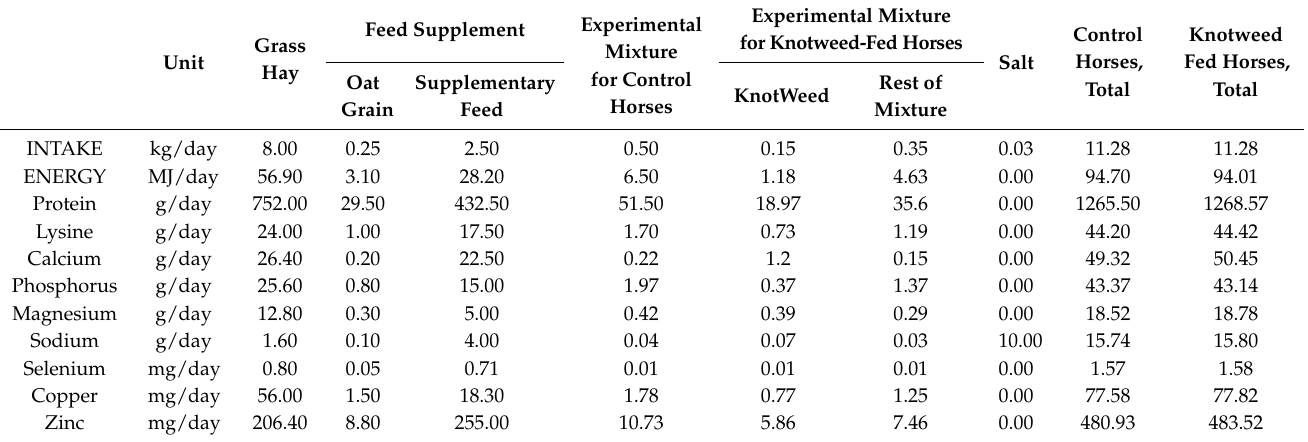
Table 1. Amounts, composition and nutrient contents of the feed for 3-year-old warmblood